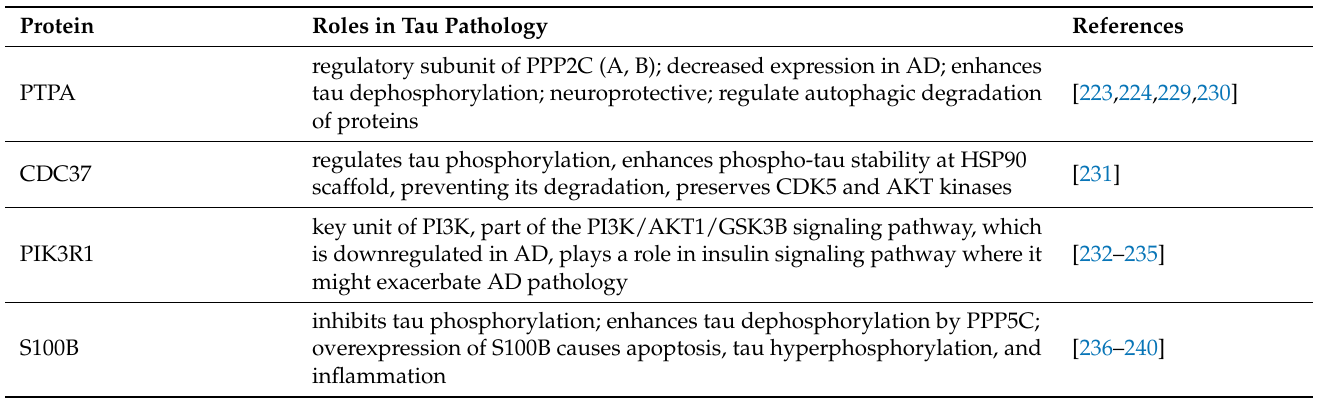
Table 4. Overview of proteins participating in the regulation of kinases or phosphatases known to interact with tau protein and their roles in